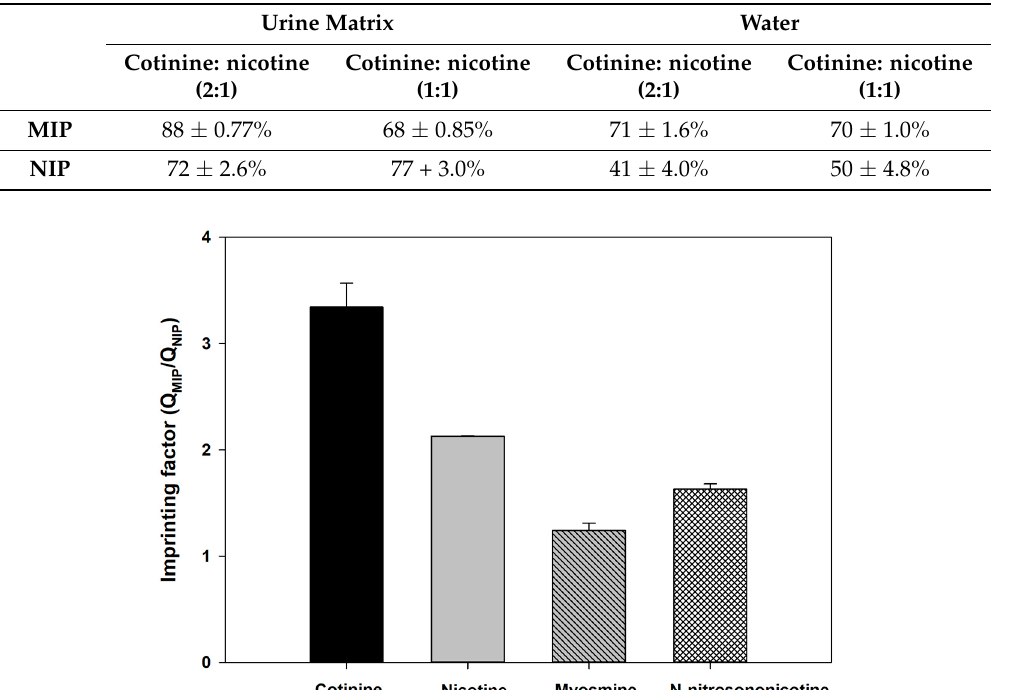
Figure 8. Selectivity of synthesized polymers. Black and gray bars represent imprinting factors for cotinine and nicotine, respectively.